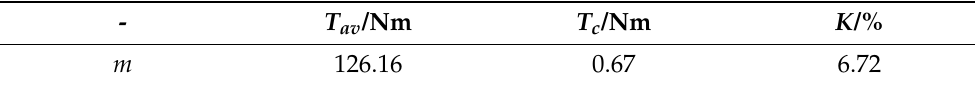
Table 8. Average results for each optimization